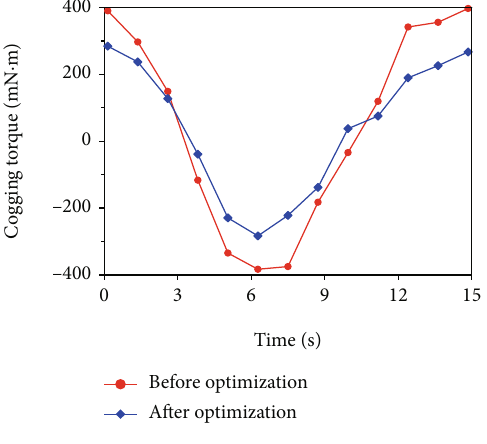
Figure 9: Cogging torque comparison.